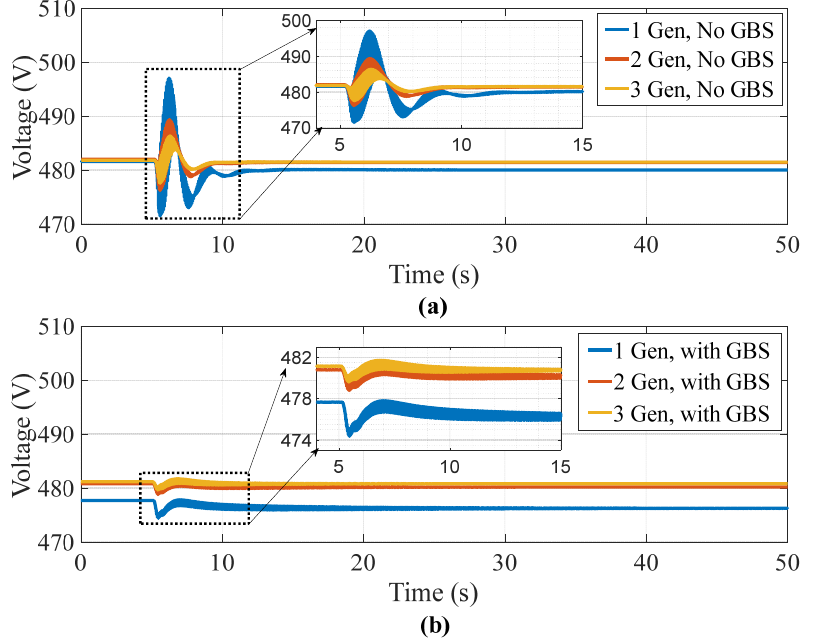
Figure 12. Voltage Dynamics during Loss of Wind Scenario under Different Number of Generators.